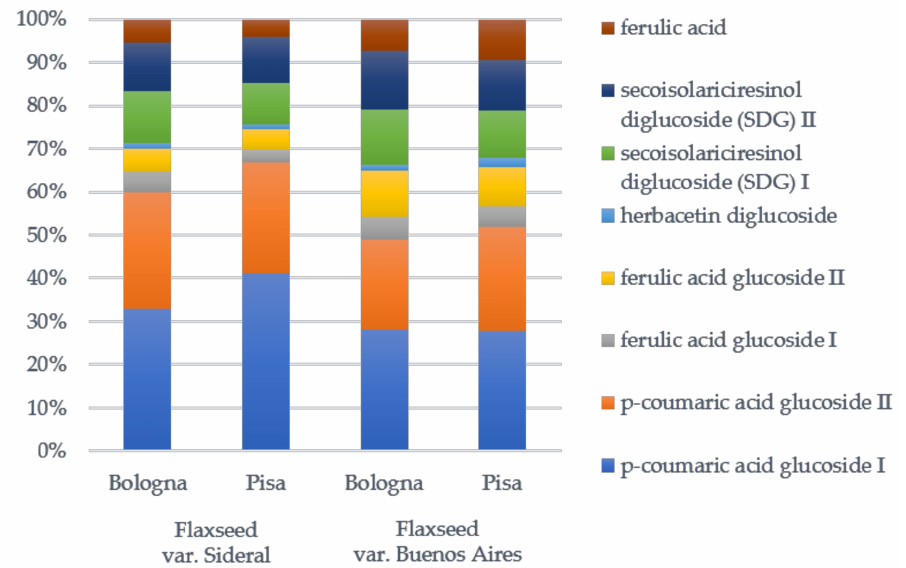
Figure 4. Percentage amount of identified phenols in secoisolariciresinol diglucoside (SDG) oligomers after the alkaline hydrolysis of flaxseed meal extracts from Sideral and Buenos Aires in two Italian cultivation sites, Pisa and